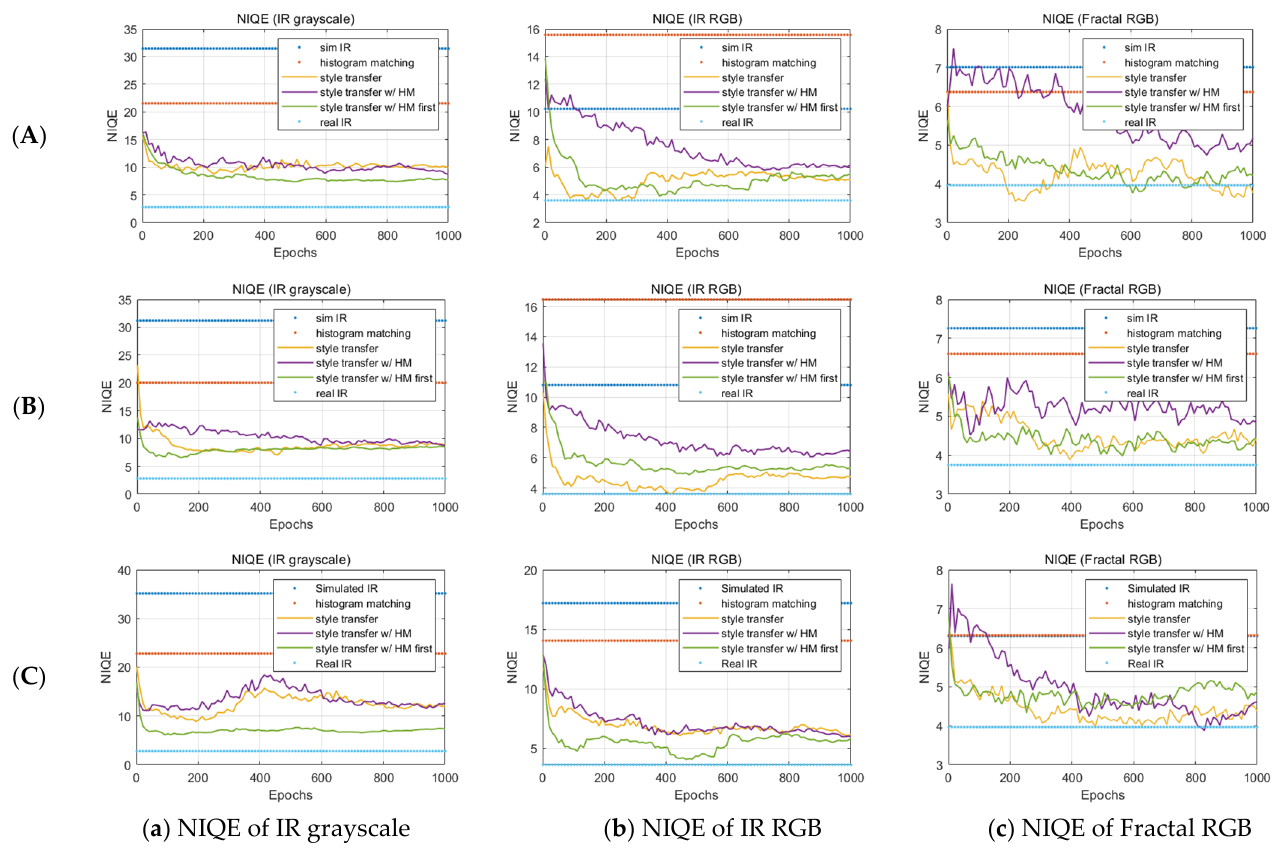
Figure 6. Results of NIQE of grayscale IR image, false-colored IR RGB image, and fractal RGB image in each of the three simulation conditions: ( A ) Cloudy summer weather at 20 h; ( B ) Fine summer weather at 20 h; ( C ) Cloudy summer weather at 10 h with the four different image generation techniques mentioned in Figure 4.